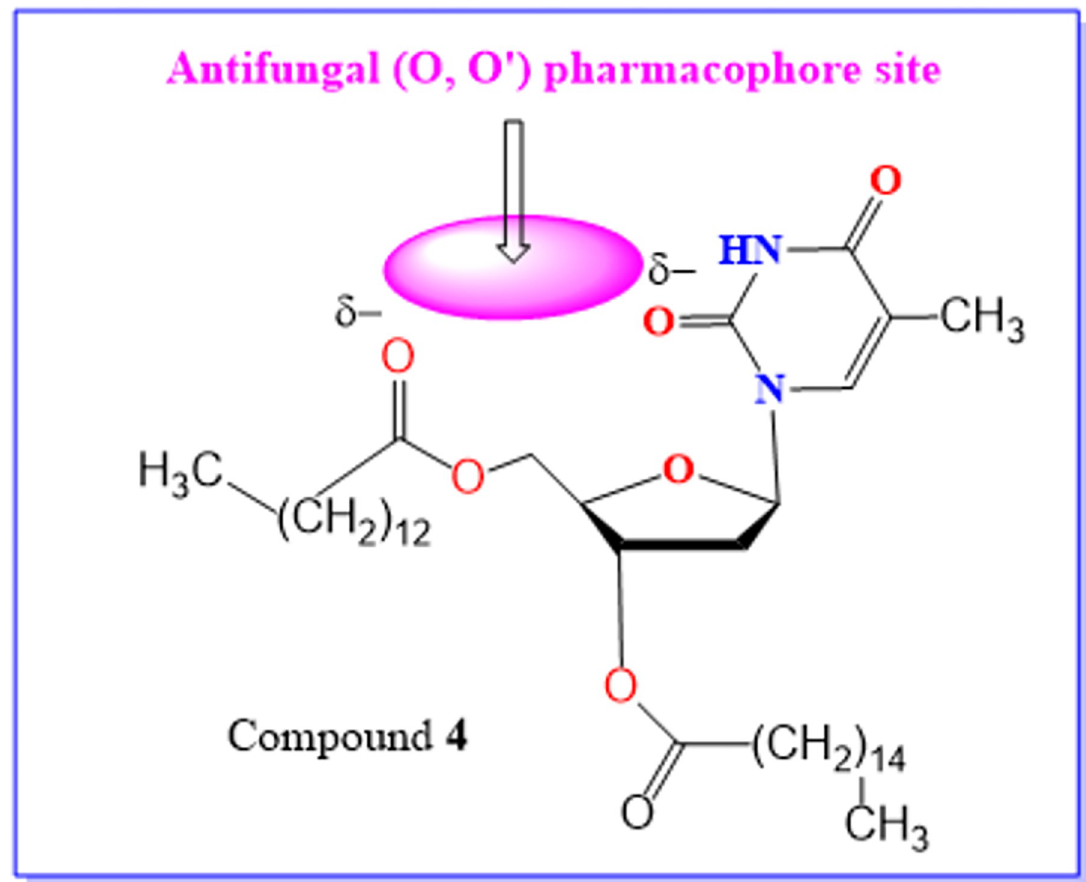
Fig 13. Identification. Antifungal/antiviral pharmacophore site of compound 4 [69–75].